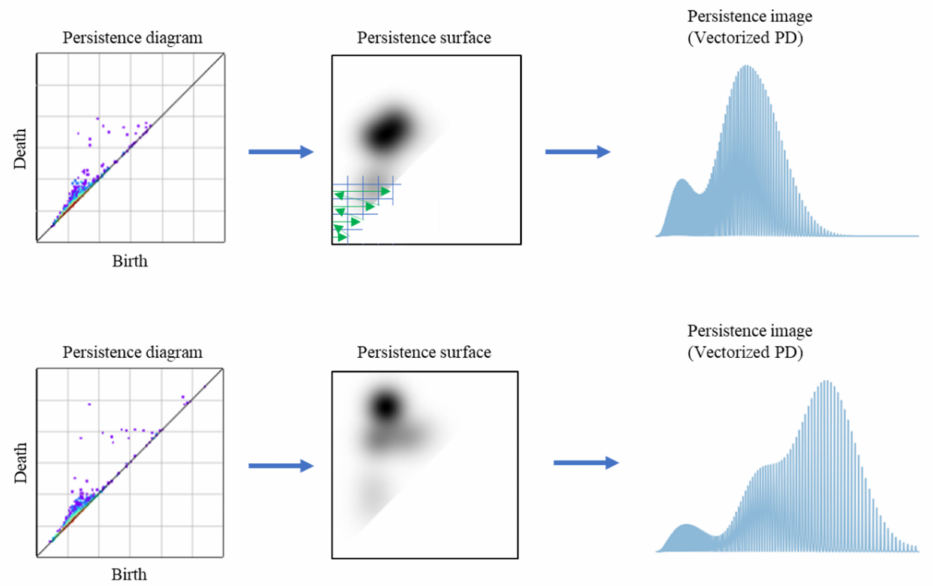
Figure 6. Schematic illustration of the vectorization procedure. The left plots include the PDs; the center figures are the persistence surfaces; and the right histograms contain the PIs. Two morphologies are vectorized in the upper and lower figure panels. As shown in the upper center figure, the persistence surface is divided by a grid, and representative values of all grid cells are arranged along the green